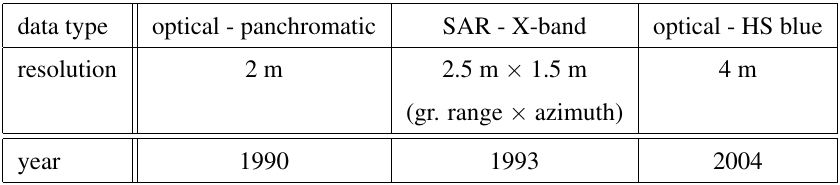
Table 2. Oberpfaffenhofen data set: images and sensors details.